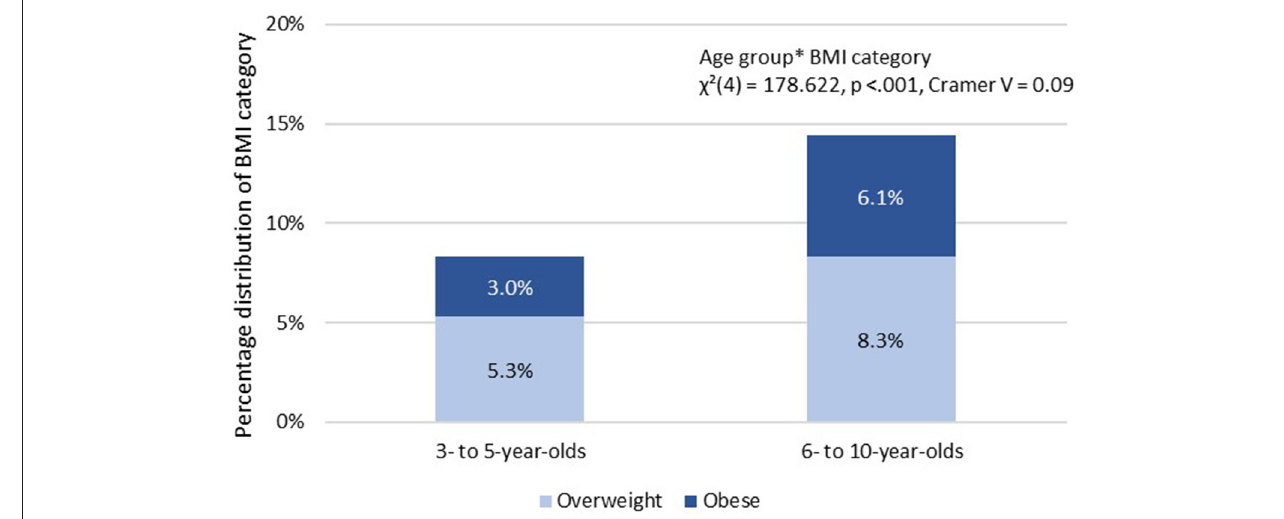
FIGURE 1 | Percentage distribution of overweight and obese within BMI category overweight between age groups.